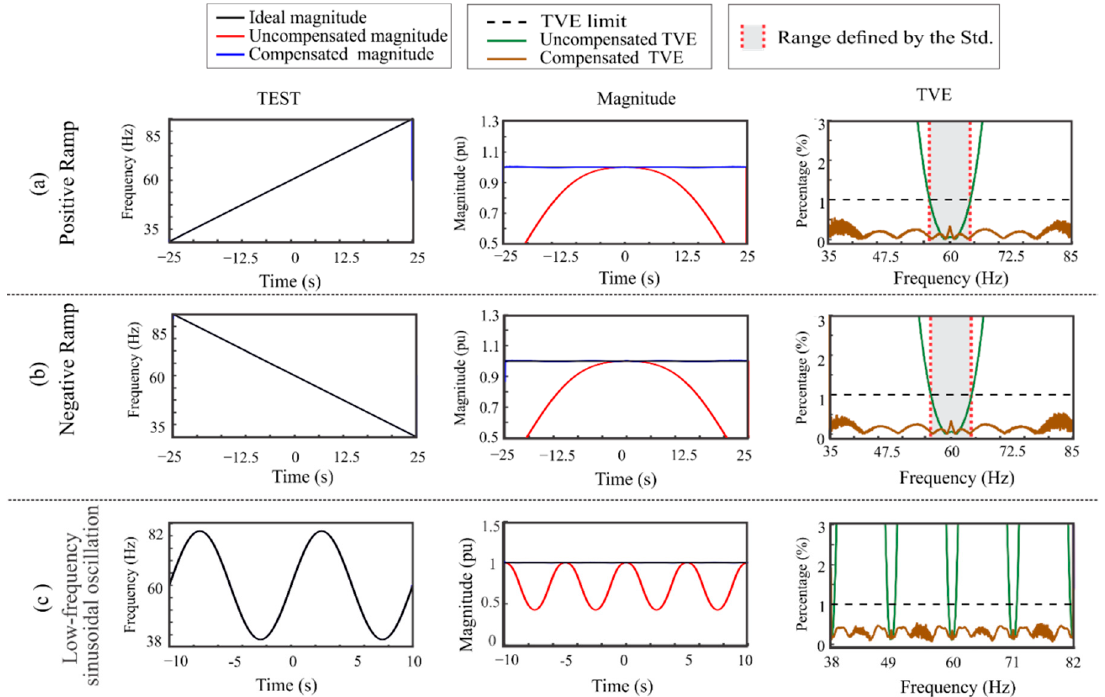
Figure 10. Experimental tests in dynamic conditions: ( a ) positive ramp, ( b ) negative ramp and ( c ) sinusoidal frequency variation test.